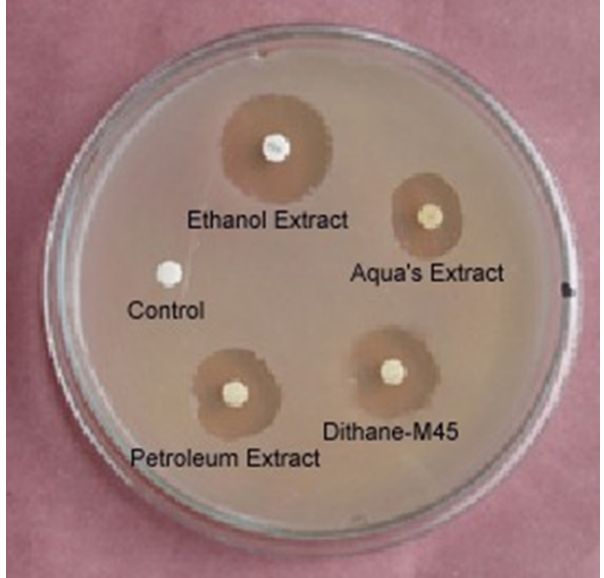
Fig. 1. Antifungal activity of water chestnut (wild